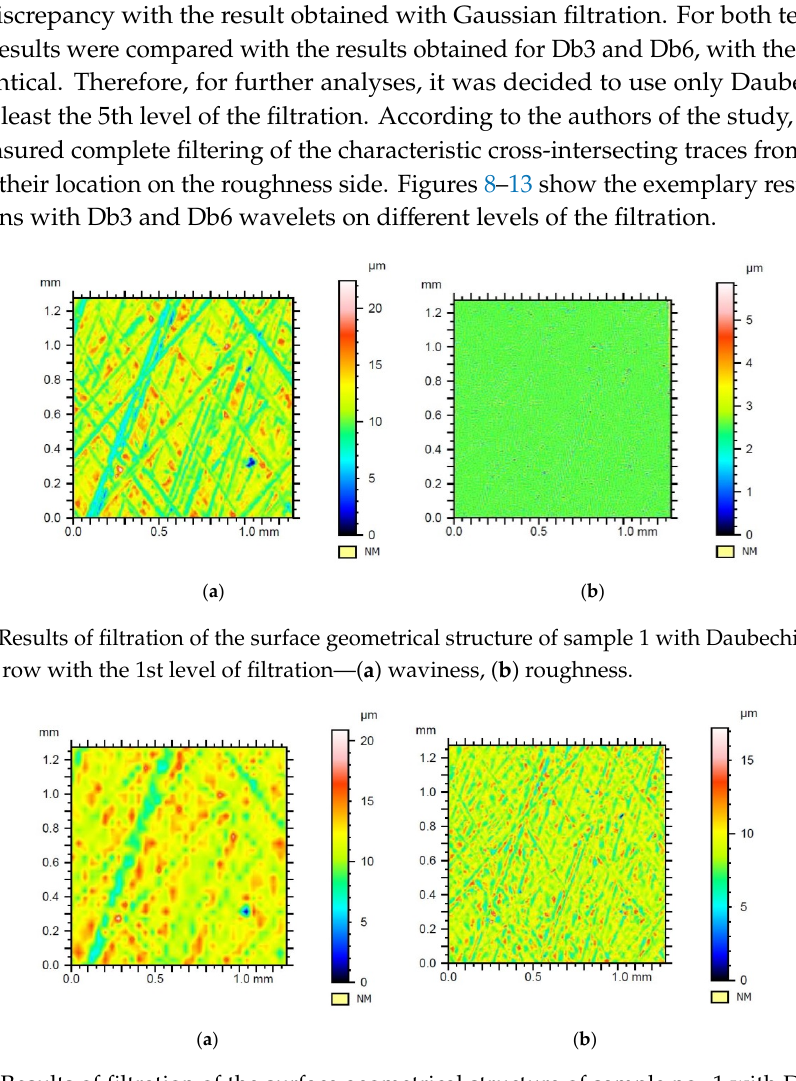
Figure 10. Results of filtration of the surface geometrical structure of sample no. 1 with Daubechies wavelet of the 3rd row on the 5th level of filtration—( a ) waviness, ( b ) roughness.